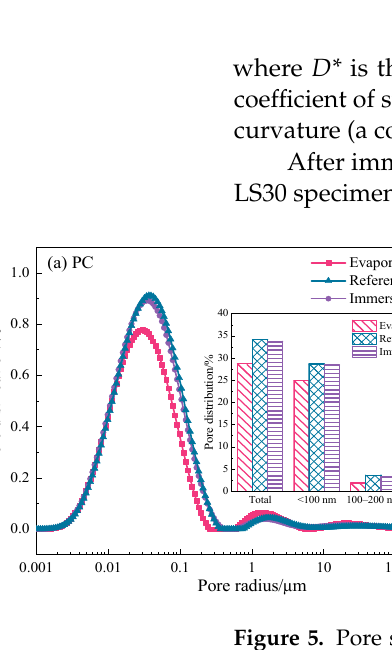
Figure 5. Pore size distribution in evaporation zone, immersion zone, and reference of partially immersed for 80 days specimens.